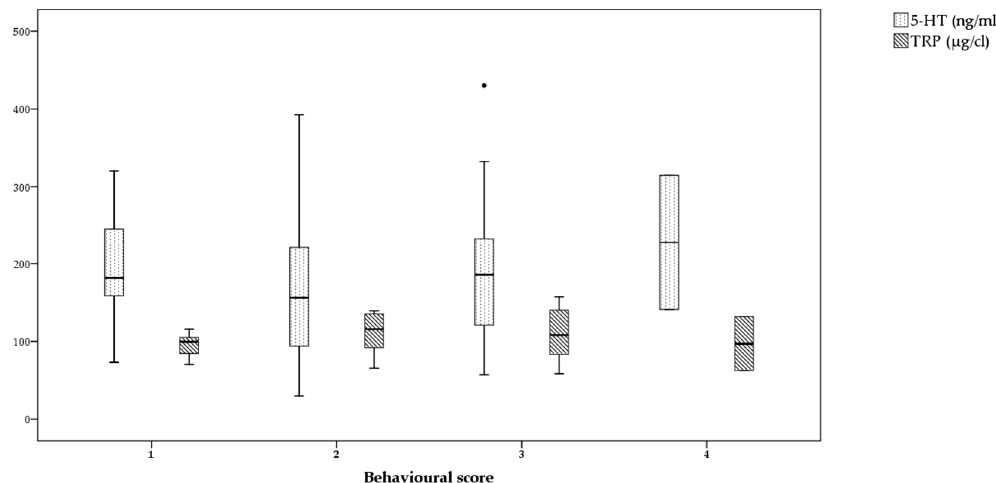
Figure 1. Tryptophan (TRP) (striped boxes) and serotonin (5-HT) (dotted boxes) concentrations (TRP: µg/cL, 5-HT: ng/mL) in dogs showing the following behavioural scores: relaxation (1), displaying stress signals (2), showing tension without growling, (3) and showing tension with growling (4) during the medical examination.